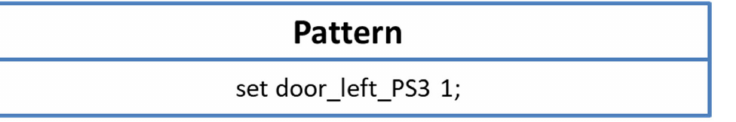
Figure 11. Query for a stimuli I.